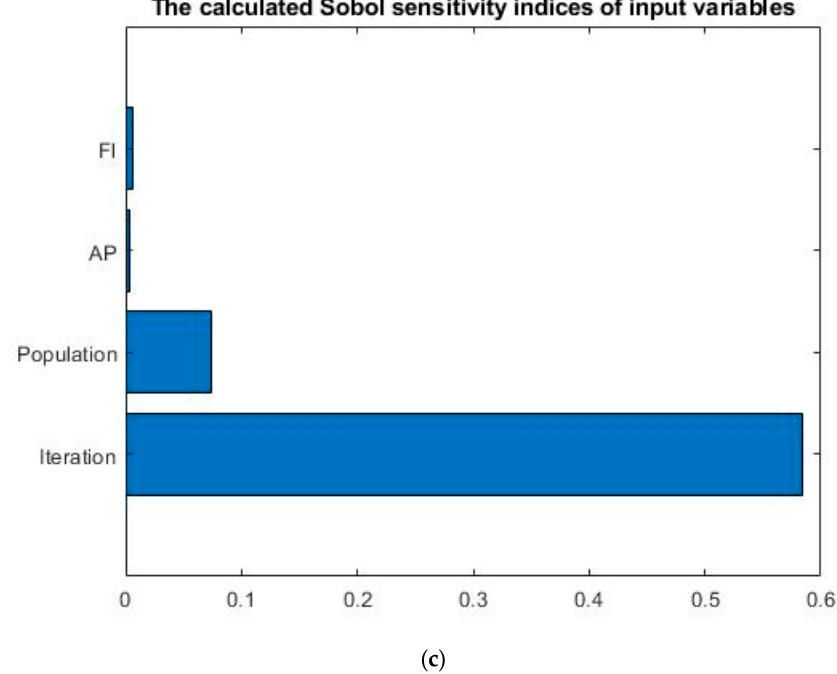
Figure 12. Sensitivity analysis on case study 1( a – c ), ( a ) Population vs. iteration for case study 1, ( b ) Awareness probability vs. iteration for case study 1 and ( c ) Sobol sensitivity index for case study 1. Table 9. Statistical data of applied metaheuristic algorithms on well placement optimization for the case study 1